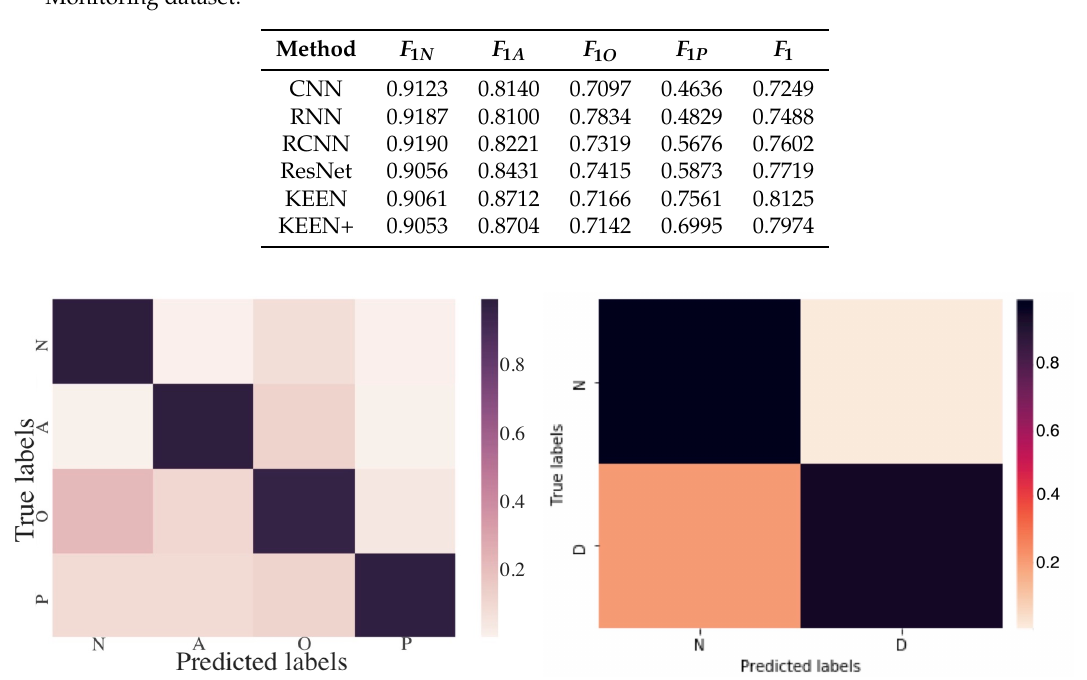
Table 2. Comparing our method with other deep learning methods on the Atrial Fibrillation Monitoring dataset.